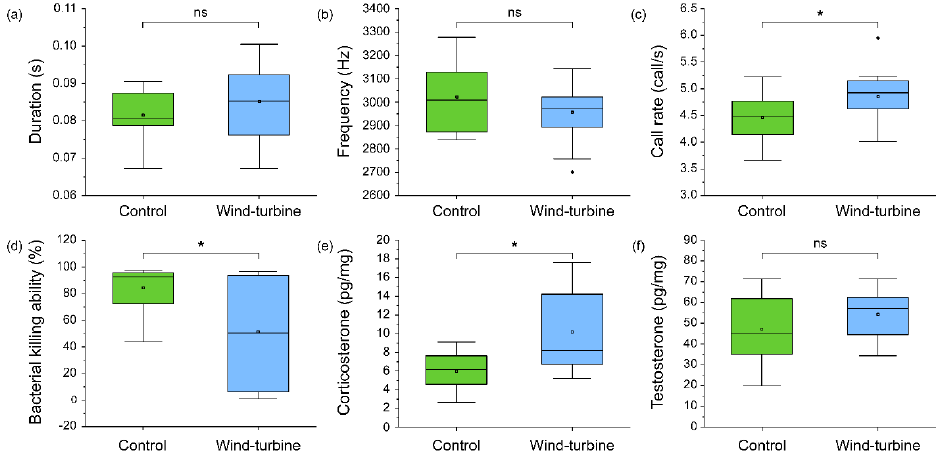
Figure 5. The difference in calling pattern, immunity, and physiological conditions between the control (green box) and wind turbine groups (blue box): ( a ) note duration, ( b ) dominant frequency, ( c ) call rate, ( d ) bacterial killing ability, ( e ) corticosterone, and ( f ) testosterone. Significant differences ( p < 0.05) were determined using an unpaired t -test (and a Mann – Whitney U-test in immunity graph) and are represented by asterisks (*).